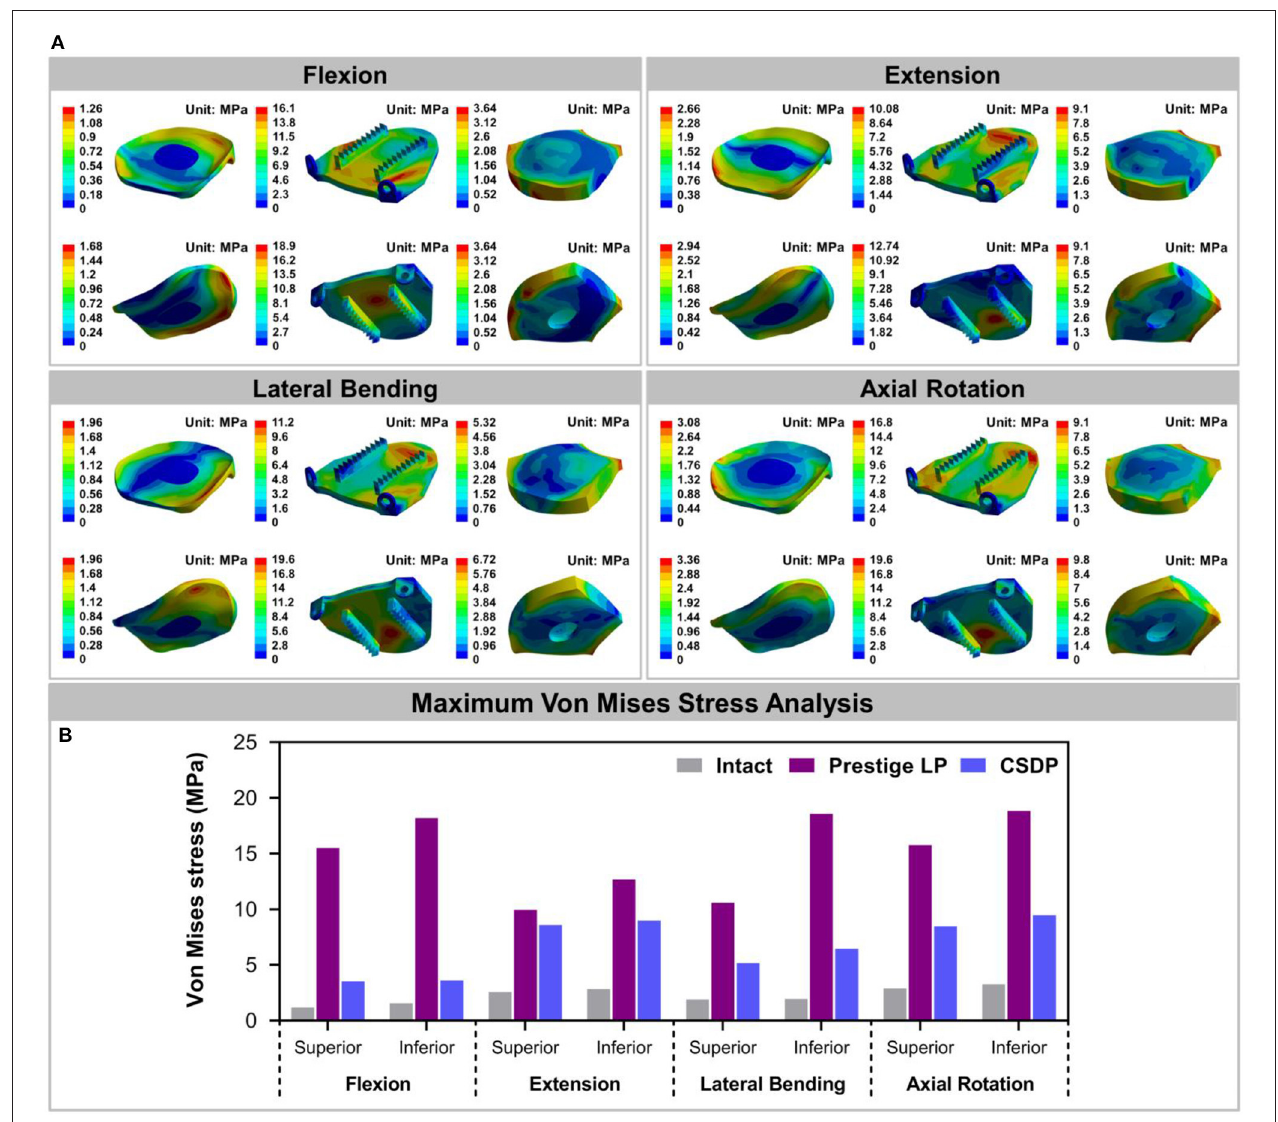
FIGURE 7 | Stress analysis of the intact finite element (FE) cervical spine model and cervical artificial disc replacement (CADR) FE models. (A) The Von Mises stress can be observed, including intact, Prestige LP, and cervical subtotal discectomy prosthesis–cervical disc prosthesis (CSDP-CDP) structure FE models in flexion, extension, lateral bending, and axial rotation loads. Stress of the Prestige LP FE model, distributed in the central region, was much higher than that of the CDP structure FE and intact FE models. Stress distribution of the CSDP-CDP structure FE model was similar to that of the intact FE model, located in the peripheral region. (B) Maximum Von Mises stress analysis of the intact, Prestige LP, and CSDP-CDP structure FE